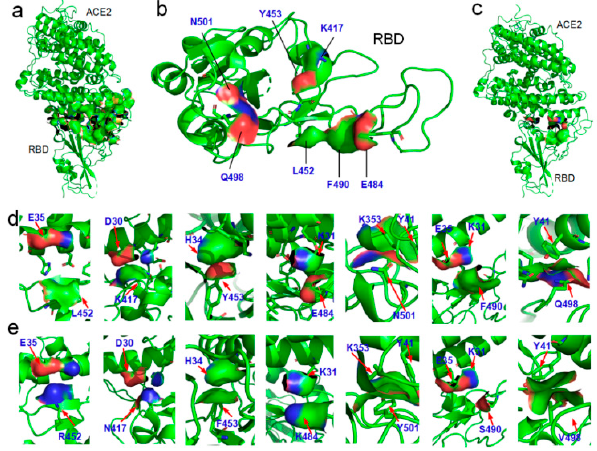
Figure 2. Binding surfaces of the RBD and the ACE2. ( a ) The RBD–ACE2 complex (PDBID: 6LZG). ( b ) The distribution of hydrophobic (green and yellow areas) and hydrophilic (red and blue areas) surface areas at the amino-acid positions L452, K417, Y453, E484, N501, F490, and Q498 of the